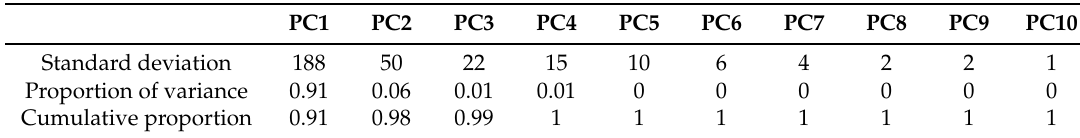
Table 1. Importance of PCs.